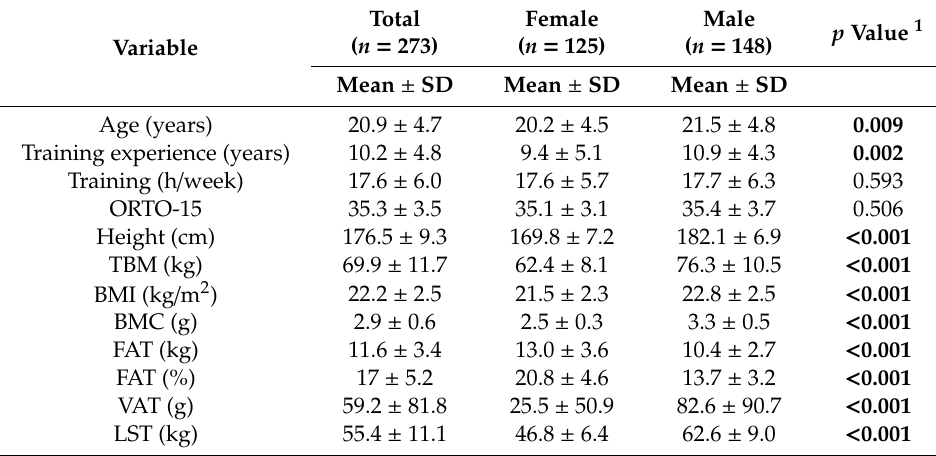
Table 2. Characteristics of subjects and statistical di ff erences by